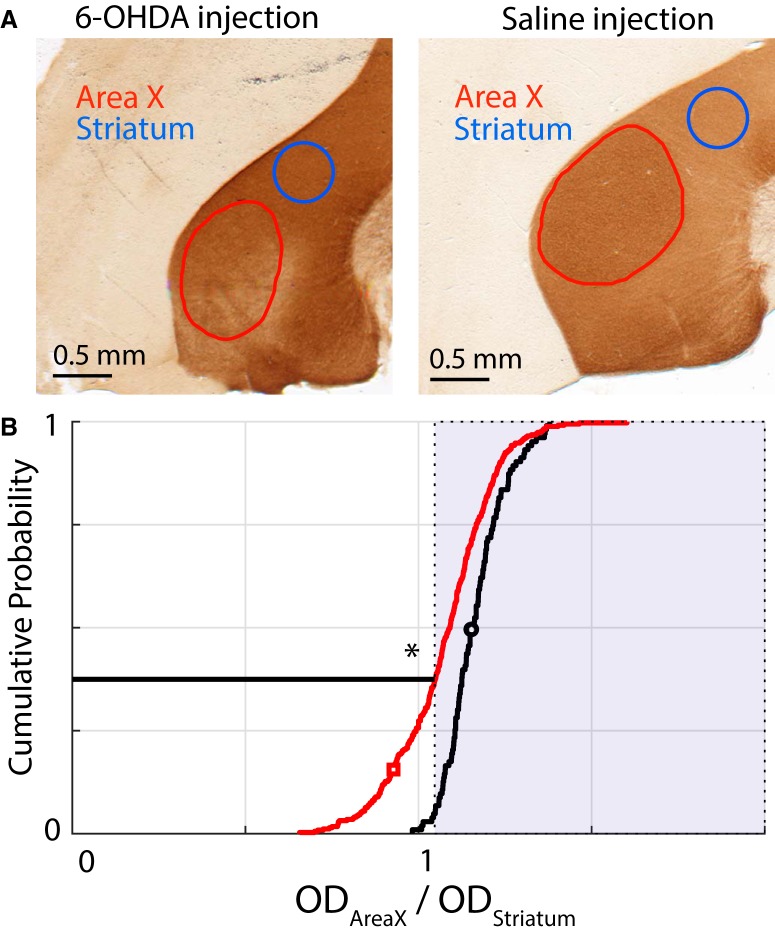
Metric for quantifying the extent of our lesions in our population of birds. We used an OD ratio between Area X and the surrounding basal ganglia (see Materials and Methods) and compared the cumulative ratios between a saline-injected population (N = 4 birds) and our 6-OHDA lesioned population (N = 16 birds). A, Examples of 6-OHDA lesioned (left) and saline-injected (right) sections. The red trace demarcates the Area X boundary. The blue circle is chosen to represent a uniformly stained section of the rest of the striatum. The ratio for each section is calculated as the OD ratio between these two regions. B, Cumulative distribution plots for the saline-injected birds (black trace) and the 6-OHDA lesioned birds (red trace). The shaded portion represents ratios that are greater than the 5th percentile for the saline-injected birds. By this metric, 37.5% of all 6-OHDA lesioned sections have a smaller OD ratio. The black and red symbols correspond to the examples shown in A. The * represents a statistically significant difference between the red trace and the black trace (Kolmogorov–Smirnov test; p < 0.05; see Results for full description).